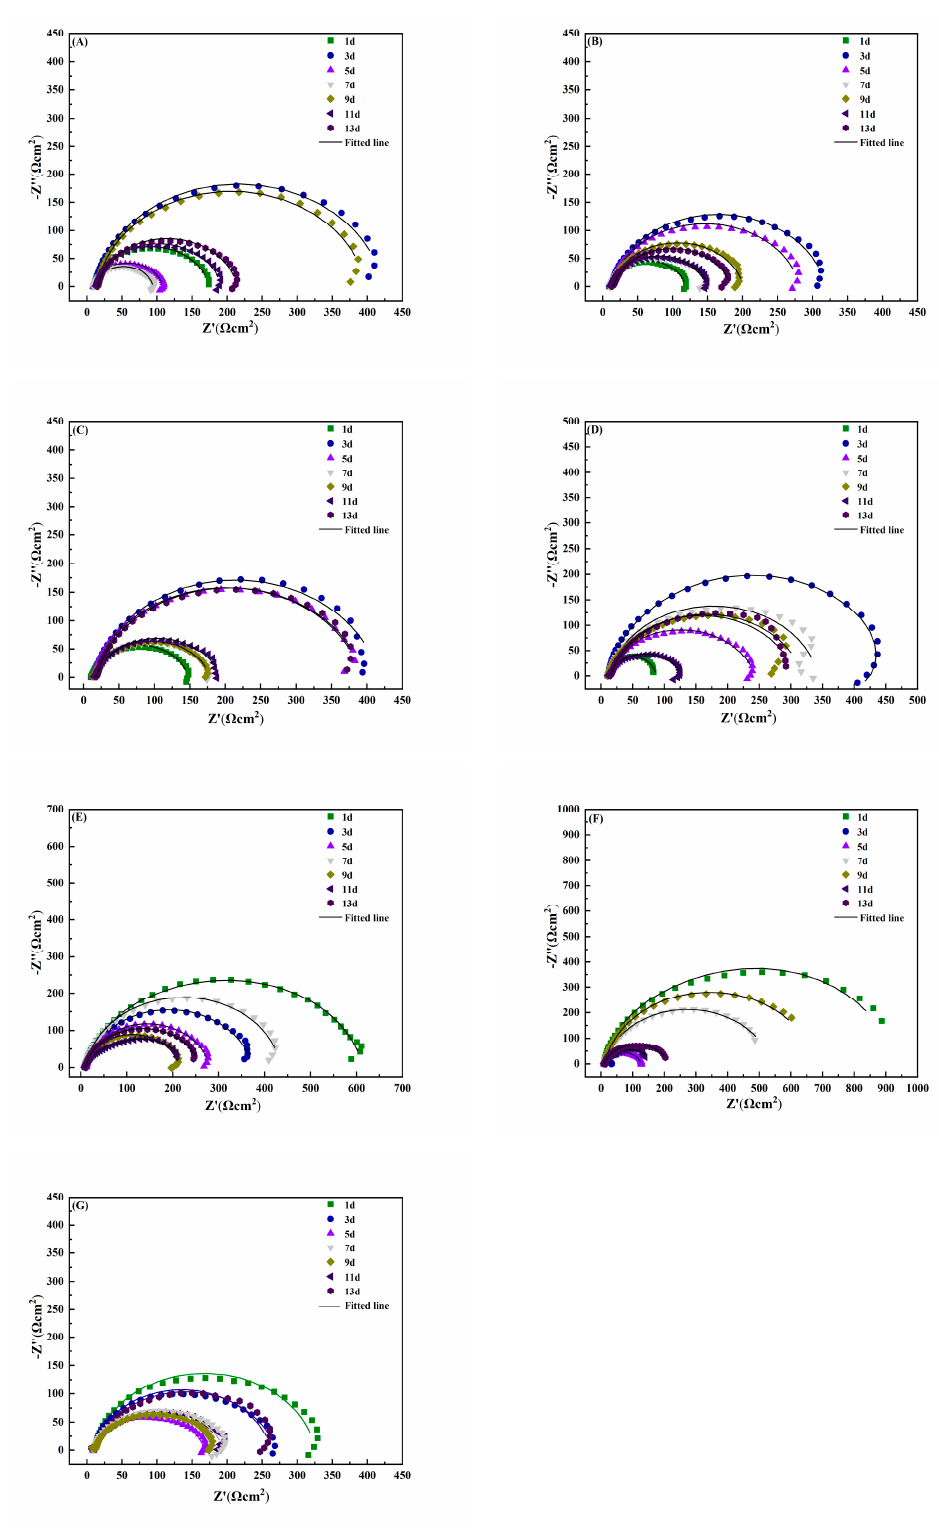
Figure 3. Electrochemical impedance spectra for AZ63B magnesium alloy soaked in 3.5% NaCl solution with different concentrations of simulated inorganic metabolites for different times. ( A – C ): soaked in 0.2, 0.4, and 0.6 mmol/L phosphate 3.5% NaCl solution; ( D – F ): soaked in 3.5% NaCl solution with 2, 4, and 6 mmol/L sulphur ion; ( G ): 3.5% NaCl solution.